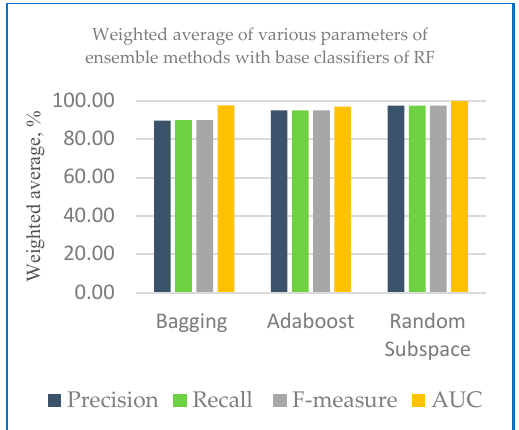
Figure 5. Weighted average of various parameters of ensemble methods with base classifiers of random forest.